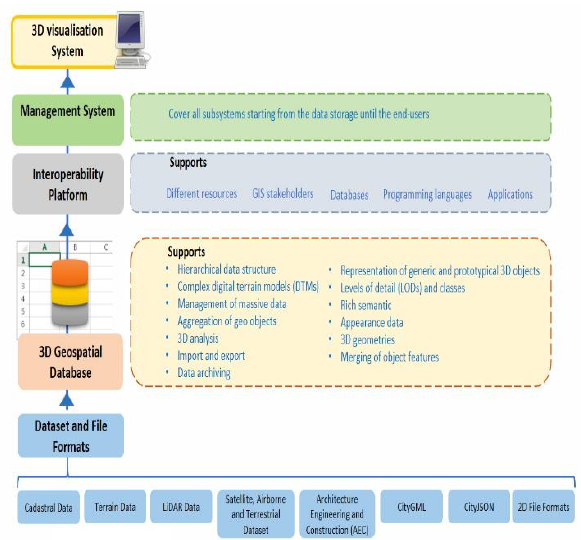
Figure 10 . Proposed 3D SDI framework for